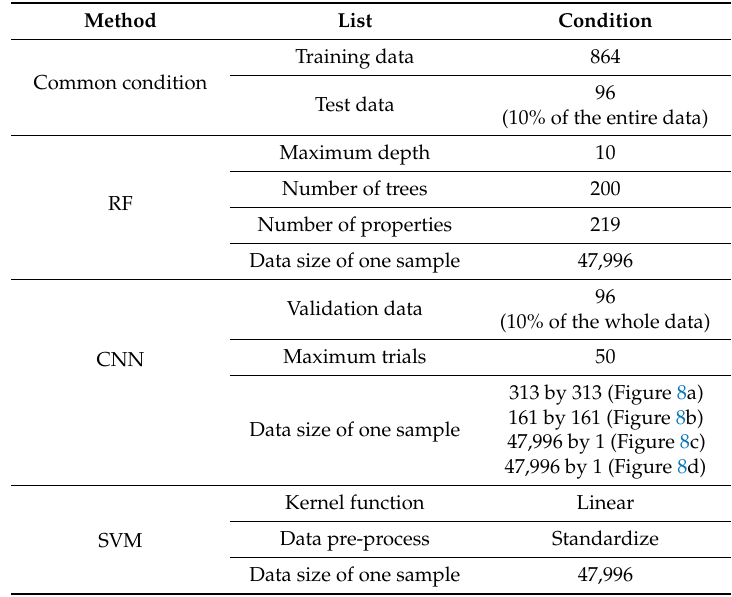
Table 2. Conditions and settings for the training of the RF, CNN, and